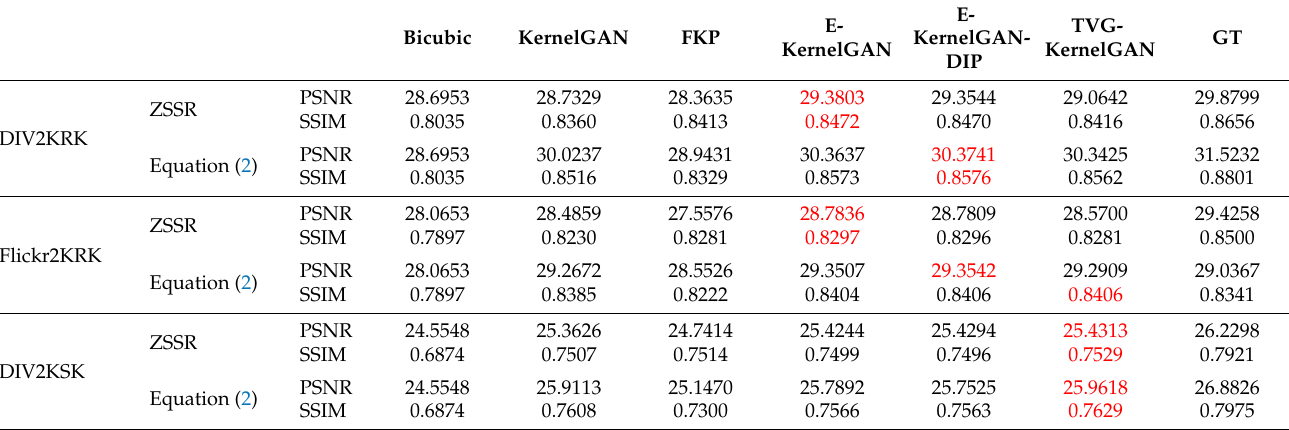
Table 2. Comparison of PSNR and SSIM scores of the SR results using estimated